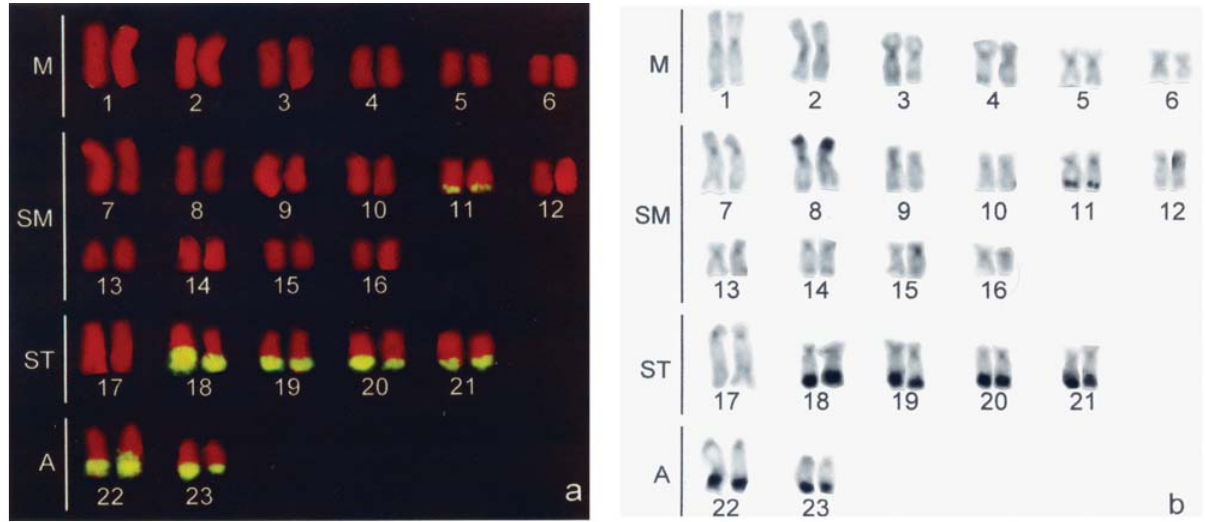
Figure 3 - Chromosomal distribution of As51 satellite DNA after FISH (a), and C-banding (b) in A. fasciatus from the Piracicaba